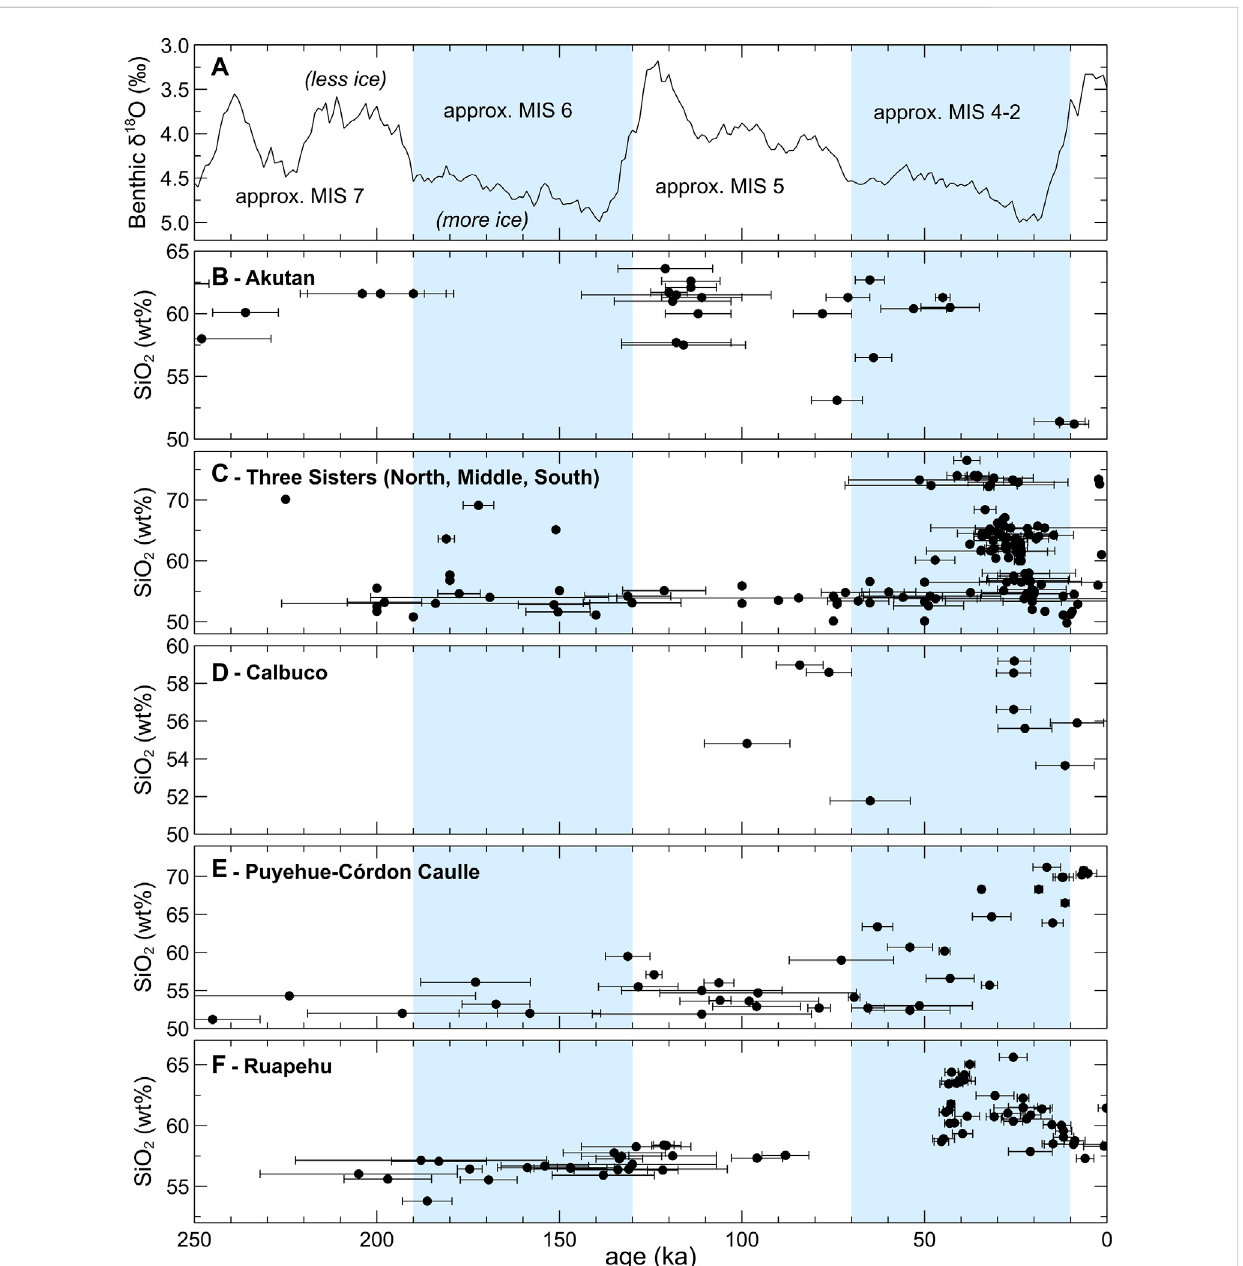
FIGURE 5 Summary of benthic δ 18 O climate proxy data (A) (Lisiecki and Raymo, 2005) and whole-rock SiO 2 contents for dated samples from the following volcanoes: (B) Akutan, Aleutians (Coombs and Jicha, 2020); (C) the Three Sisters (North, Middle and South), Cascades (Calvert et al., 2018) — note that some samples lack age errors; (D) Calbuco, Chile (Mixon et al., 2021); (E) Puyehue-Córdon Caulle, Chile (Singer et al., 2008); (F) Ruapehu, New Zealand (Gamble et al., 2003; Conway et al., 2016; Conway et al., 2018). Compositional diversity is generally greatest in MIS 4 – 2 (all volcanoes shown), but similar diversity also occurs in MIS 6 (Three Sisters) and MIS 5 (Akutan and